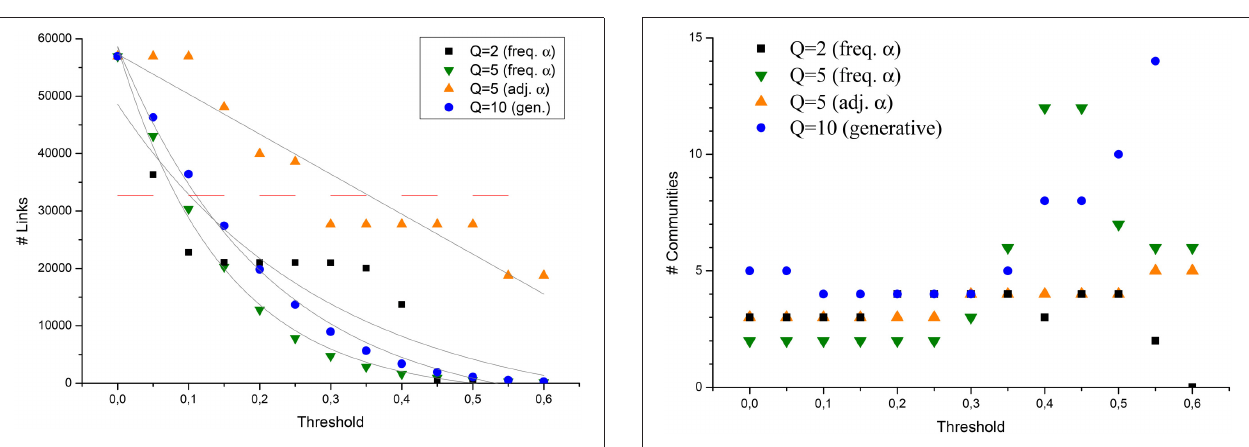
FIGURE 1 | Number of links detected by the Potts-LBP approach in the original graph, against the t m threshold parameter, for some of the reconstruction approaches discussed in the text. The dashed red line indicated the number of links detected with the Jaccard method. exponential decay in the number of detected links 24 . Several